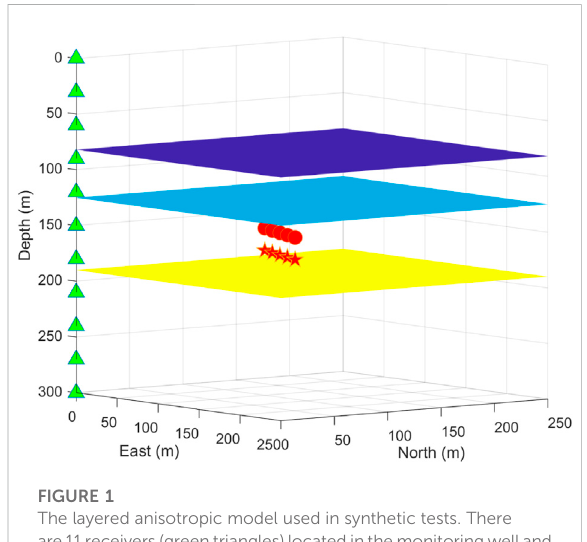
The layered anisotropic model used in synthetic tests. There are11receivers(greentriangles)locatedinthemonitoringwelland twofracturesystemsinthethirdlayer,whichisassociatedwith fi ve microseismic events (red stars and red dots).